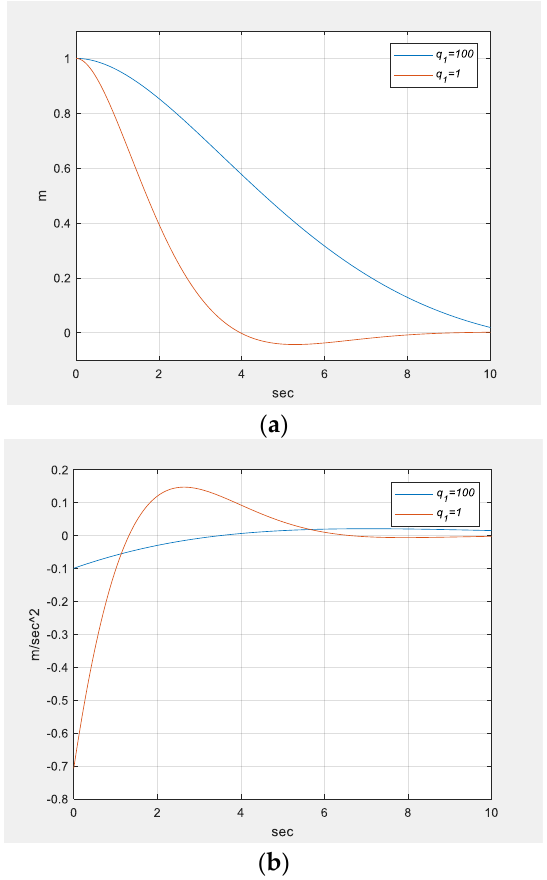
Figure 27. Optimal control when input specific force is 0: ( a ) Displacement result; ( b ) Specific force result